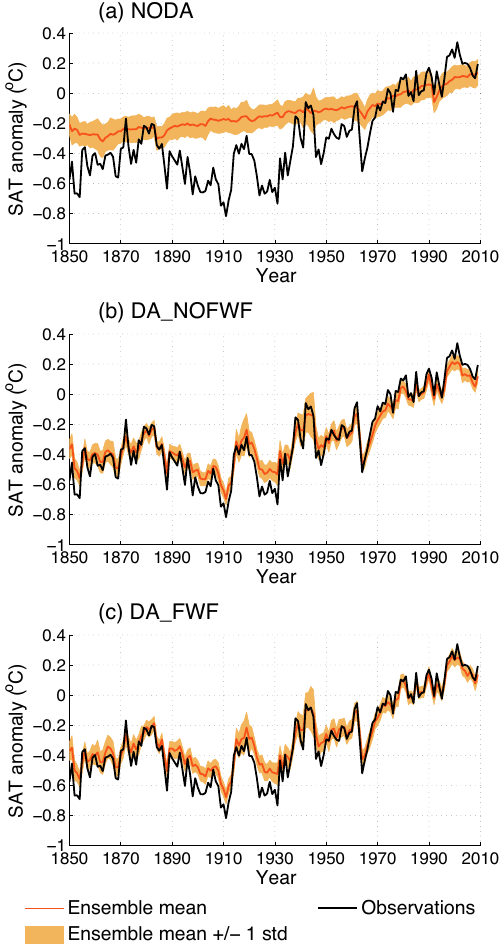
Figure 5. Yearly mean surface air temperature anomalies with re- gard to 1961–1990, averaged over the area south of 30 ◦ S, from (a) the model simulation without data assimilation (NODA), (b) the model simulation that assimilates anomalies of surface air temper- ature (DA_NOFWF) and (c) the model simulation that assimilates anomalies of surface air temperature and that is forced by an addi- tional autoregressive freshwater flux following Eq. (1) (DA_FWF). The model ensemble mean is shown as the orange line, surrounded by one standard deviation shown as the light orange shading. Ob- servations (Brohan et al., 2006) are shown as the black